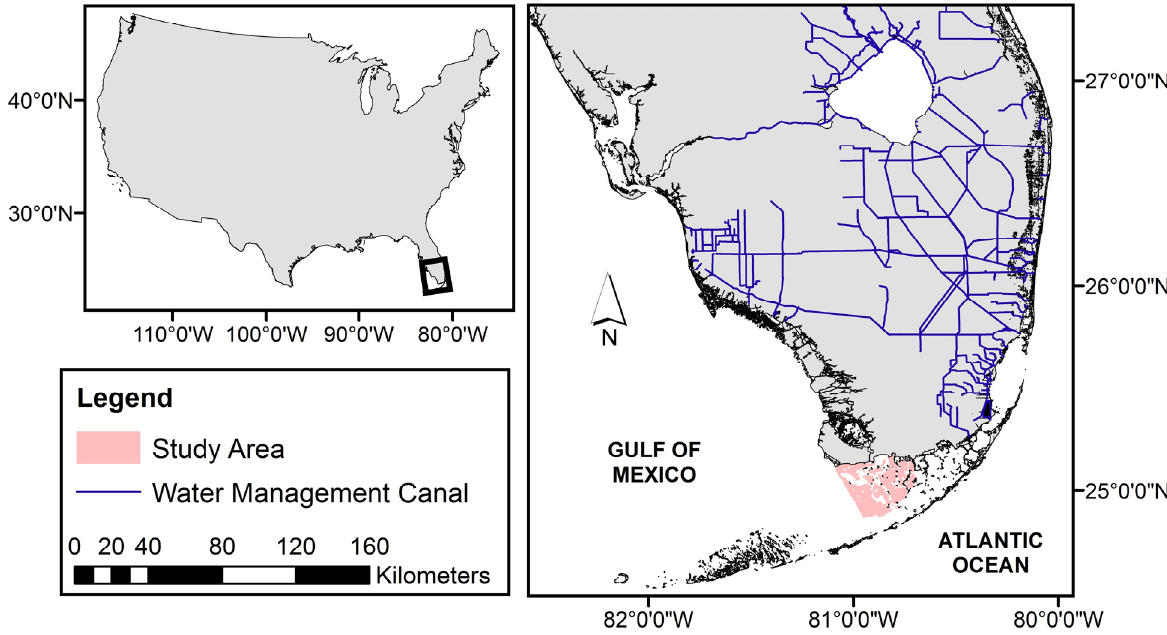
Figure 1. Map showing location of the study area in western Florida Bay, Florida, USA. The sediments of Florida Bay are mostly composed of biogenic carbonate muds [37] colonized by seagrass beds that occur over 95% of the bottom of Florida Bay [38]. Thalassia testudinum , turtle grass, is the dominant species in both distribution and biomass and is the climax species in this system